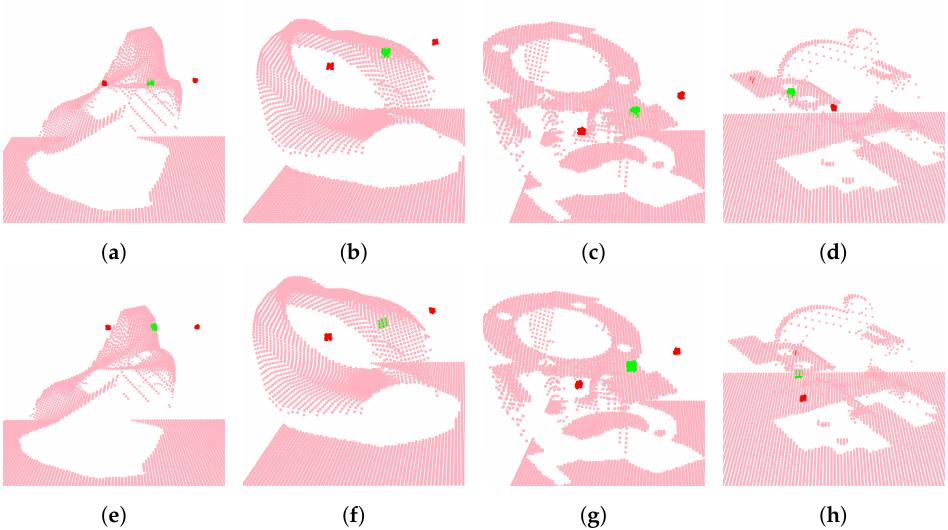
Figure 20. Visualization of grasps. (green) Grasp point; (red) indication of gripper fingers. The top row shows ground truth grasps, and the bottom row shows